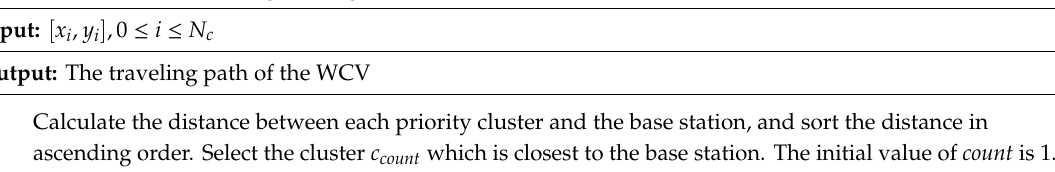
Algorithm 1. The nearest neighbor algorithm.